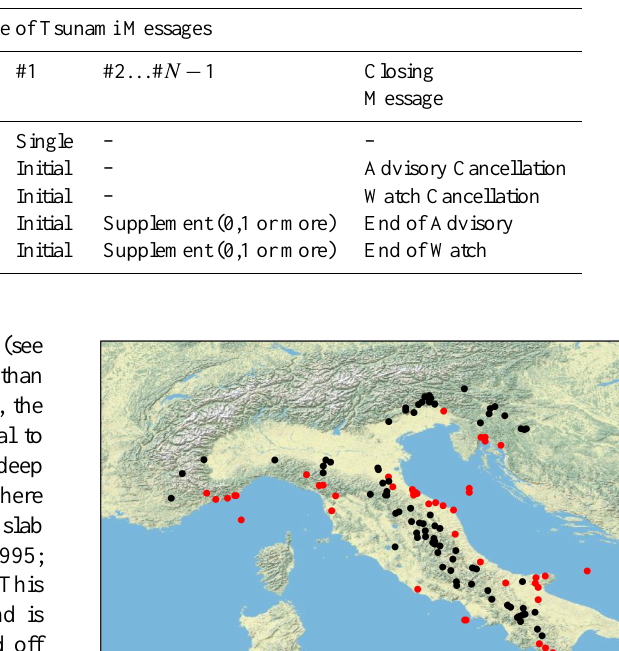
Table 5. Sequence of tsunami messages as defined by the ICG/NEAMTWS in the 2010 OUG.